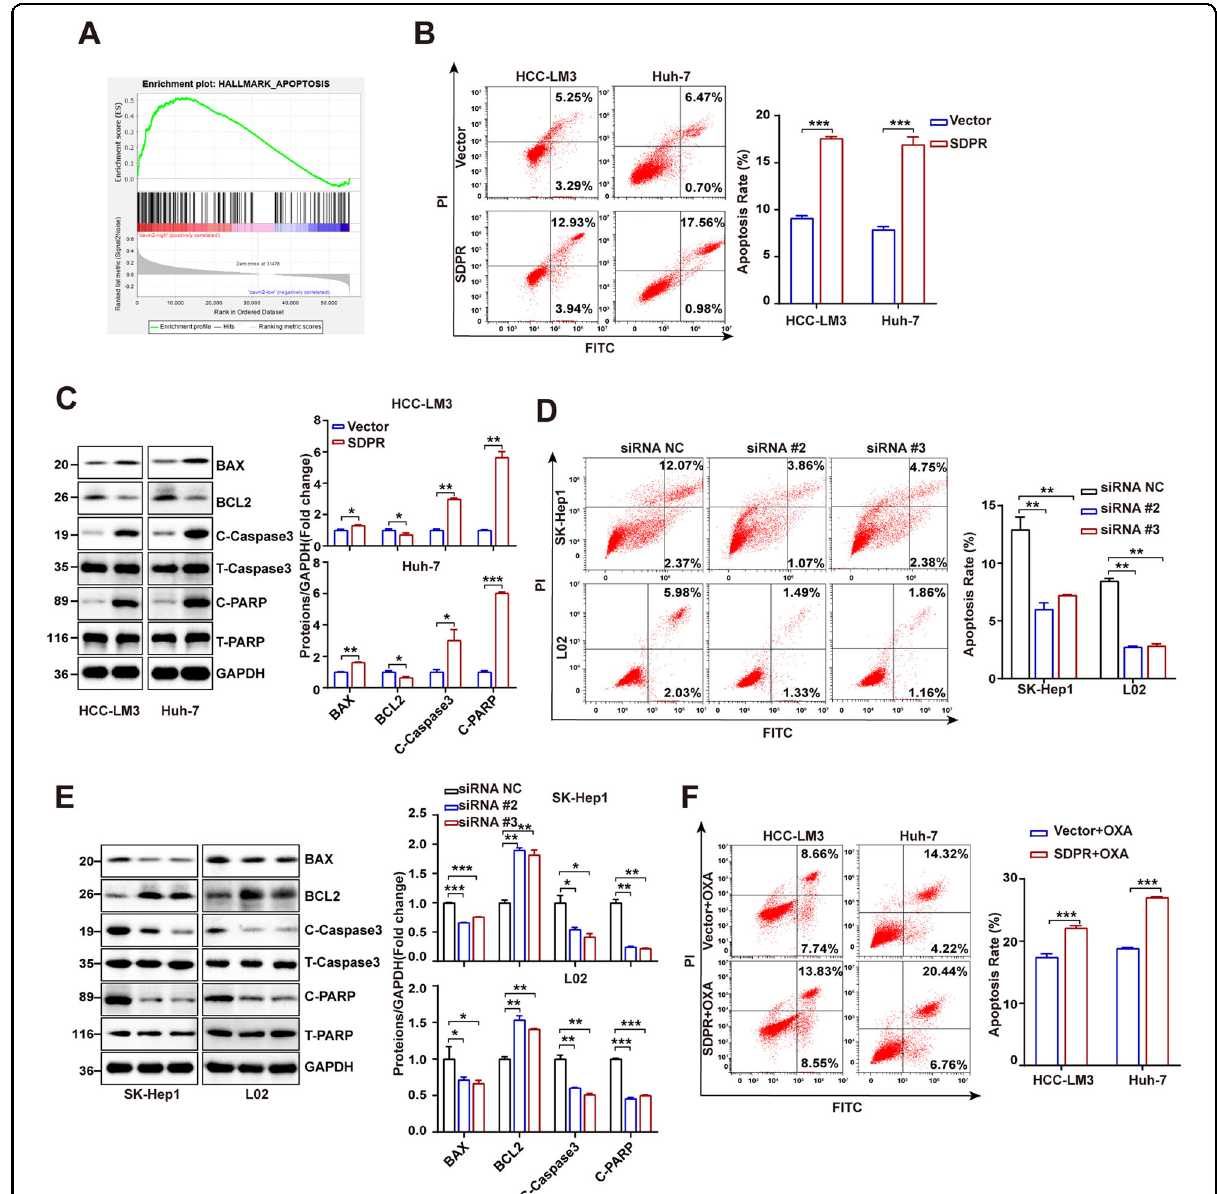
Fig. 4 SDPR activated apoptosis signaling pathway and induced cell apoptosis. A Positive enrichment for the gene signature associated apoptosis between the low and high SDPR expression groups of TCGA dataset. B SDPR overexpression promoted cell apoptosis in HCCLM3 and Huh- 7 cell lines. C The changes of apoptosis-related proteins in SDPR overexpressing HCCLM3 and Huh-7 cell lines. D SDPR-depletion inhibited cell apoptosis in SK-Hep1 and L02 cell lines. E SDPR knockdown changed the level of apoptosis-related proteins. F SDPR signi fi cantly promoted OXA- induced HCC cell apoptosis. * p < 0.05; *** p < 0.01; *** p <